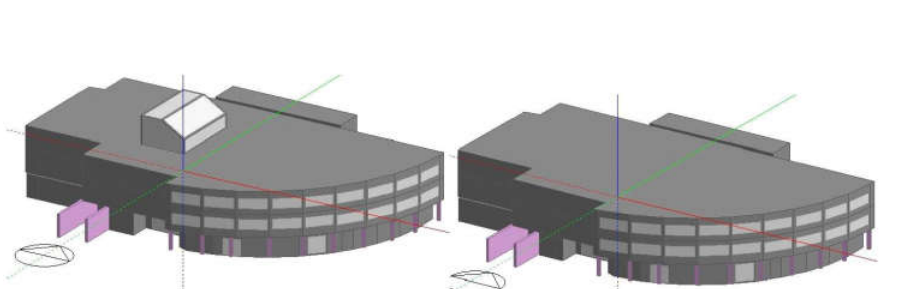
Fig. 2: Physical characteristics of models; With regular (Right) and Atrium(Left) Design